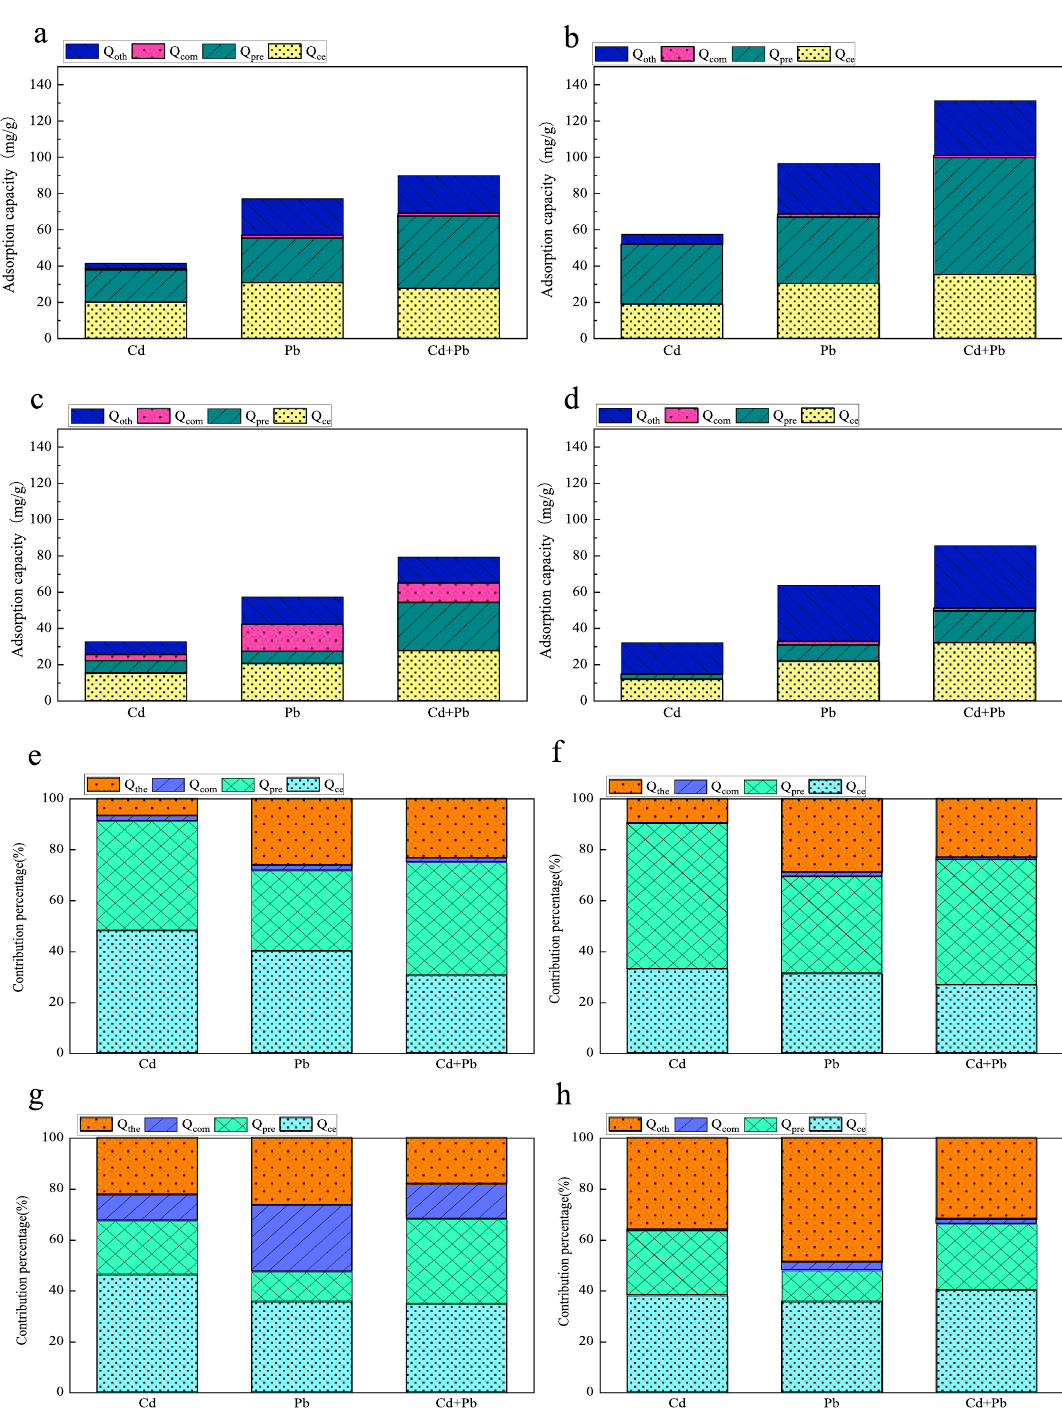
Figure 7. The quantitative contribution of Q ce , Q com , Q pre and Q oth to the adsorption of Cd 2+ and Pb 2+ on biochar: ( a and e for CB350, b and f for CB650, c and g for CCB350, and d and h for CCB650,